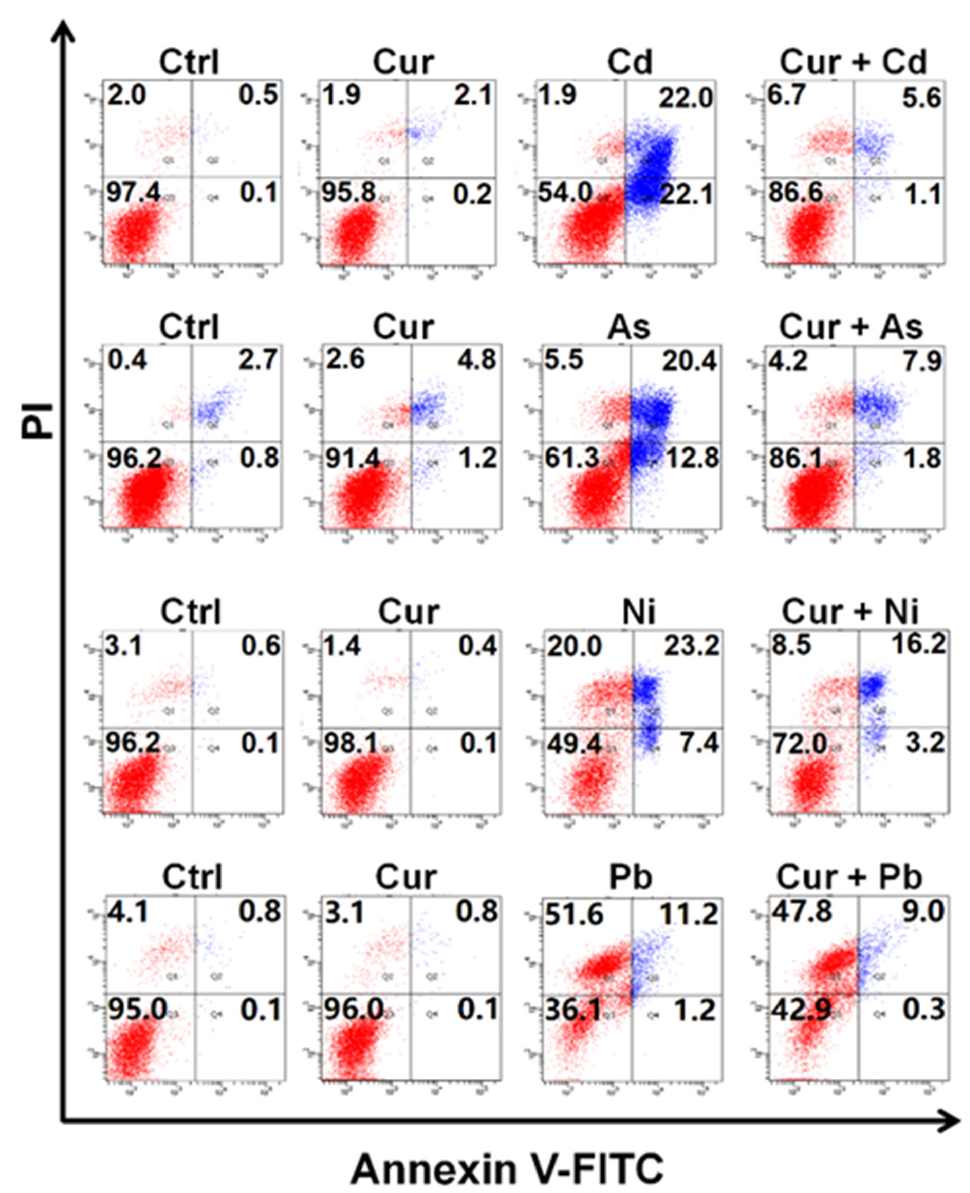
Figure 3. The apoptotic levels of HepG2 cells co-exposed to curcumin and various heavy metals. The concentrations of curcumin and heavy metals were 20 µ M for curcumin, 6 µ M for Cd, 100 µ M for As, 2 mM for Ni and 2.5 mM for Pb, respectively. To further verify the antagonistic effects of curcumin on the cytotoxicity induced by distinct heavy metals, LDH release was analyzed for evaluating the ability of curcumin to restore the membrane damage caused by heavy metals. As depicted in Figure 4, all four types of heavy metals, including Cd, As, Ni, and Pb, significantly destructed the cellular membrane and sharply up-regulated the level of LDH released into the cell culture medium. Pre-treatment with curcumin inhibited the LDH release induced by Cd, As, Ni and Pb from 1003.91 ± 102.87 ( p < 0.001) to 242.09 ± 33.66 ( p < 0.001), 810.05 ± 15.32 ( p < 0.001) to 595.06 ± 76.94 ( p < 0.01), 359.37 ± 20.53 ( p < 0.001) to 362.31 ± 43.83, and 537.39 ± 66.25 ( p < 0.001) to 513.53 ± 63.16, respectively (Figure 4). The antagonistic effects of curcumin on LDH release were 75.89%, 26.54%, 0% and 0.41% for Cd, As, Ni and Pb, separately (Figure